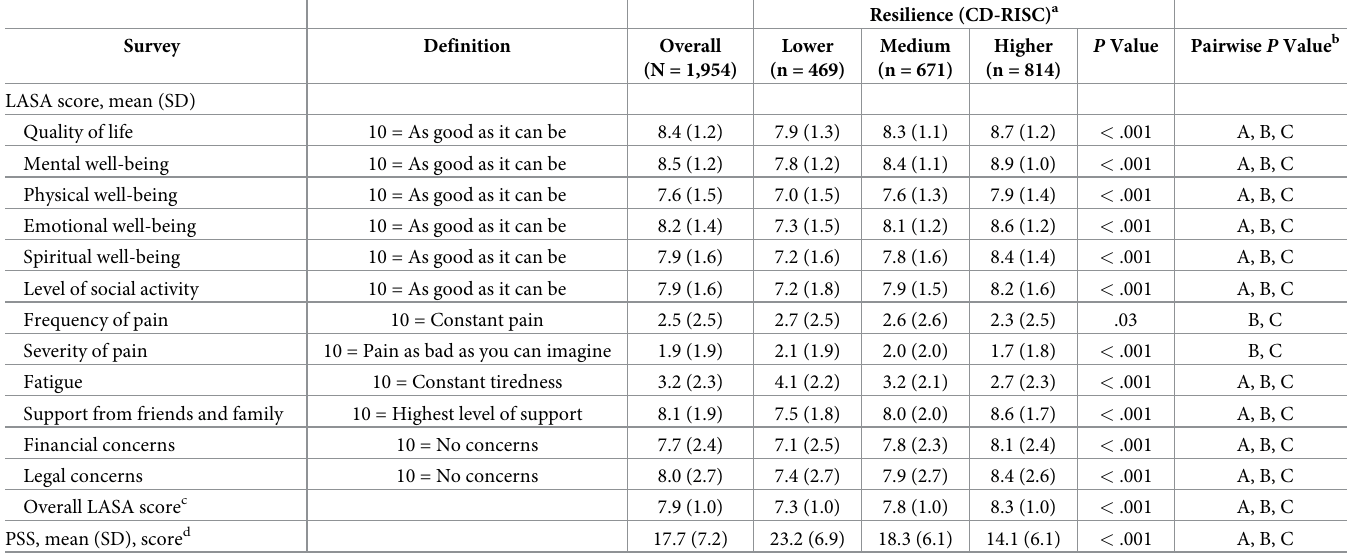
Table 2. LASA and PSS scores, stratified by resilience